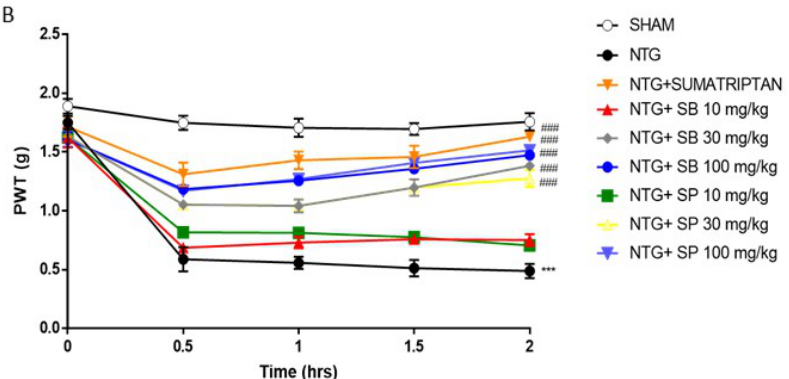
Figure 1. SCFAs treatment attenuates hyperalgesia and pain. SCFAs treatment at the higher doses of 30 and 100 mg/kg significantly increased thermal pain sensation compared to NTG group ( A ). Additionally, the von Frey test revealed that SCFAs treatments at higher doses significantly increased paw-withdrawal thresholds compared to the NTG group ( B ); *** p < 0.001 vs. sham, and ### p < 0.001 vs. NTG.